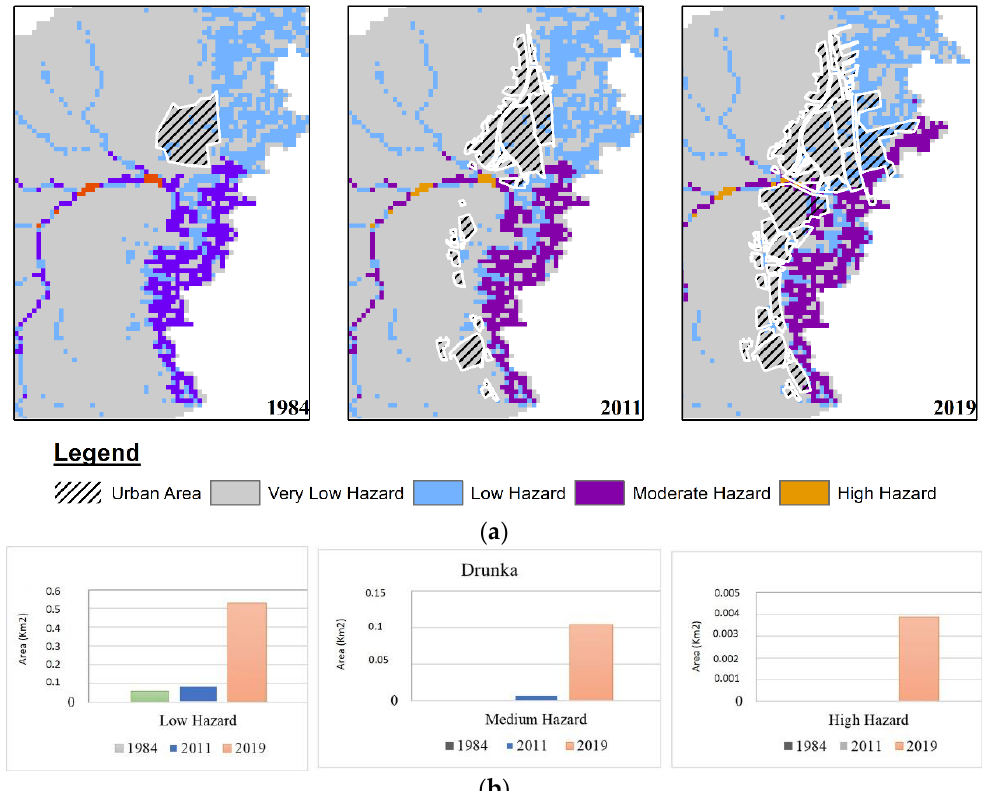
Figure 15. Inundation maps showing the hazard levels affecting the urban areas ( a ) and estimates of the vulnerable areas for flood hazard categories ( b ) over time from 1984 to 2019 in Drunka.